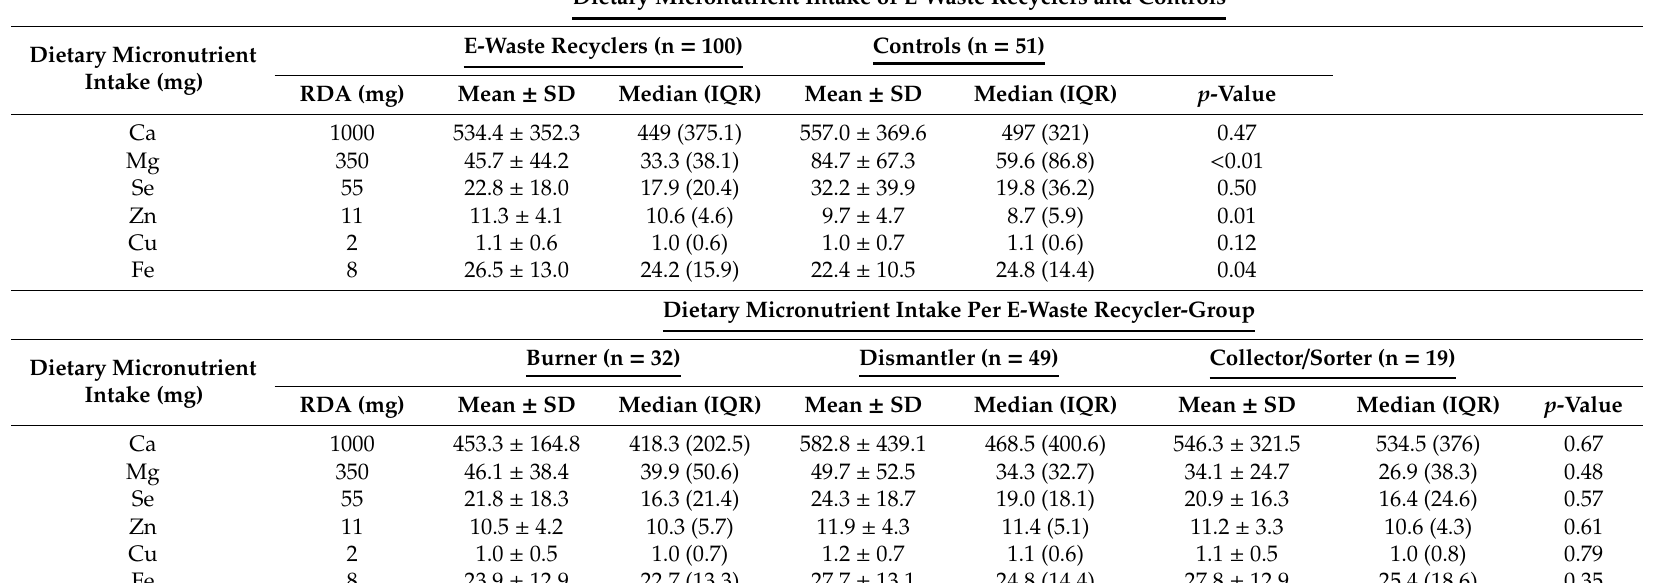
Table 2. Dietary micronutrient intake (based on food models) of participants. Dietary Micronutrient Intake of E-Waste Recyclers and